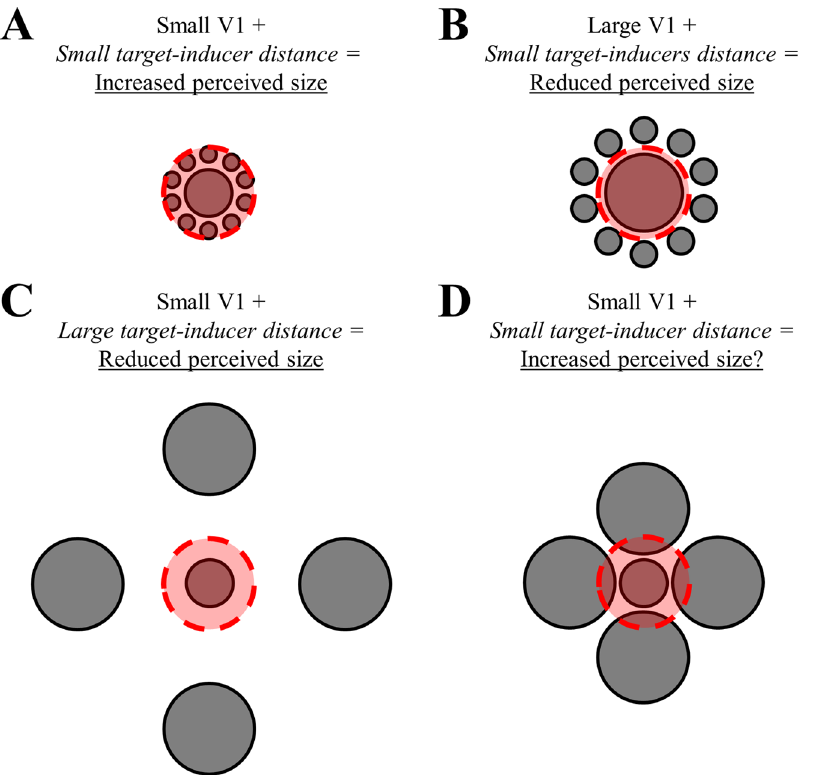
Figure 6. Schematic illustration of the relationship between cortical representation of the target-inducers distance and illusion strength. A. In a small V1, the target-inducer distance is small and thus falls within a constant range (dashed and shaded red circle). This affords a perceived size increase of the target. B. In a large V1, the target-inducer distance is greater than the constant range. This affords a perceived size reduction of the target. C. For large inducers, even in a small V1 the target-inducer distance is large and thus falls outside the constant range. In all situations this results in a perceived size reduction. D. Theoretically, if large inducers were positioned such that the target-inducer distance falls within the constant range, a size increase should be perceived. Some readers may in fact confirm this effect by visual inspection of this